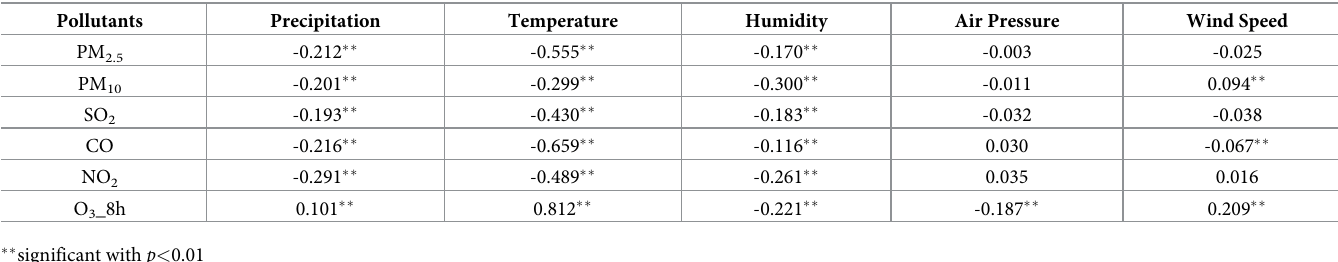
Table 3. Correlation coefficients between main pollutants and meteorological factors in